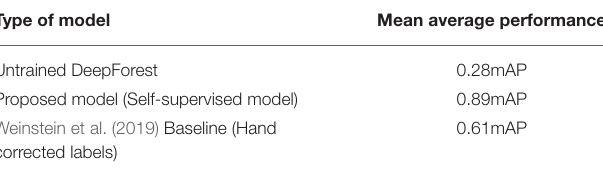
TABLE 3 | Tree crown recognition results on images from Cambridge